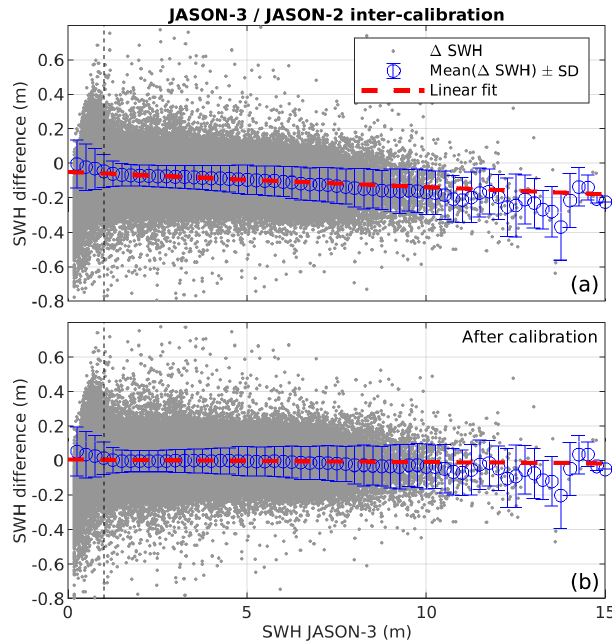
Figure 4. Residual of JASON-1 SWH − JASON-2 SWH as a func- tion of JASON-1 SWH before (a) and after (b) calibration. The dashed red line is a linear fit through the data.